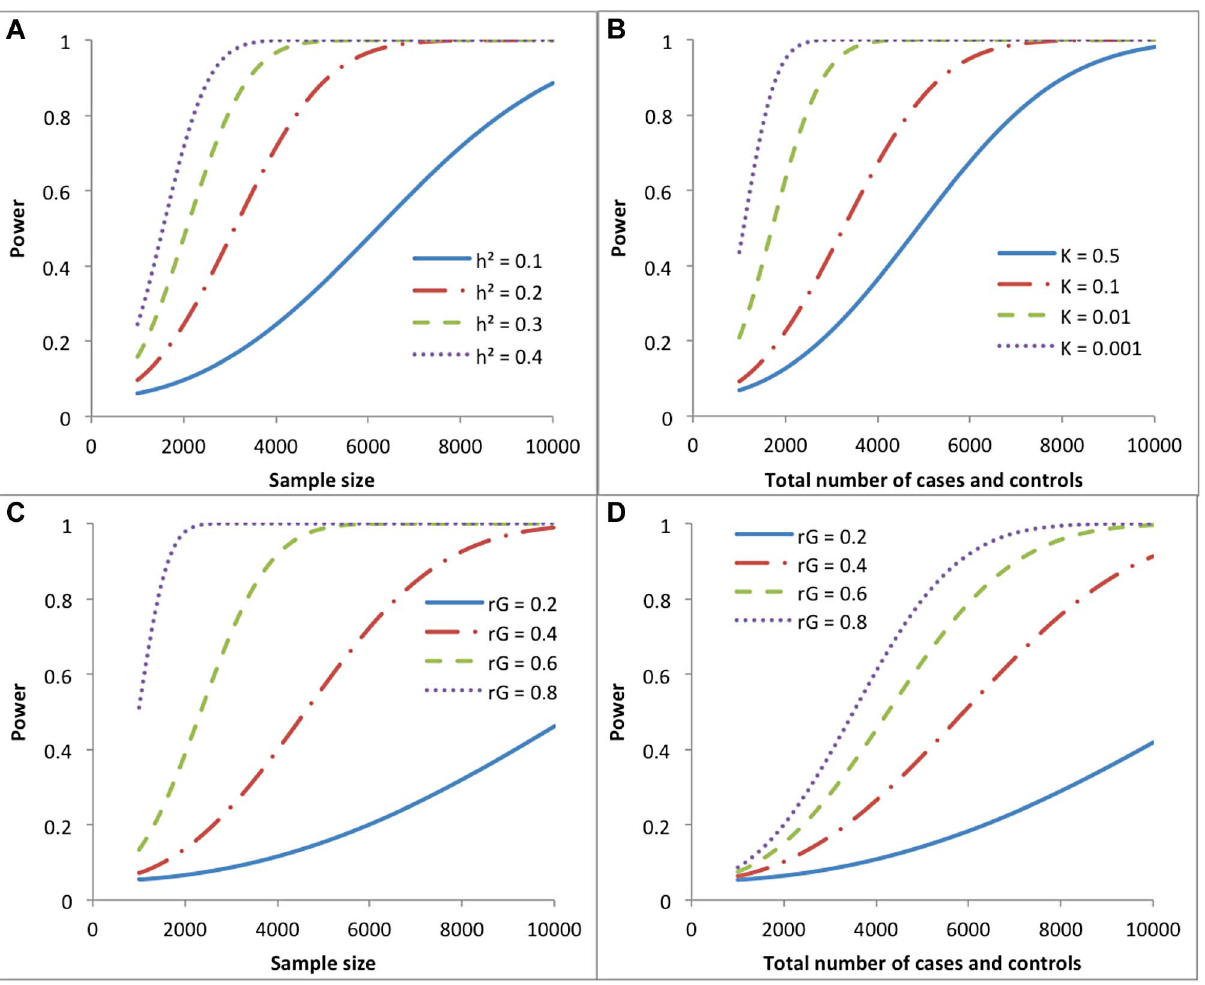
Figure 3. Statistical power of detecting genetic variance (correlation) under different study designs. a ) Univarite analysis of a quantitative trait. b ) Univariate analysis of a case-control study assuming equal number of cases and controls ( v =0.5) and heritability of liability ( h 2 of 0.2. c ) Bivariate analysis of two quantitative traits measured on the same set of individuals, assuming heritability of 0.2 for both traits. d ) Bivariate analysis of two case-control studies on independent sets of samples, assuming equal numbers of cases and controls for each disease, and equal sample size (total number of cases and controls), equal heritability of liability ( h 2